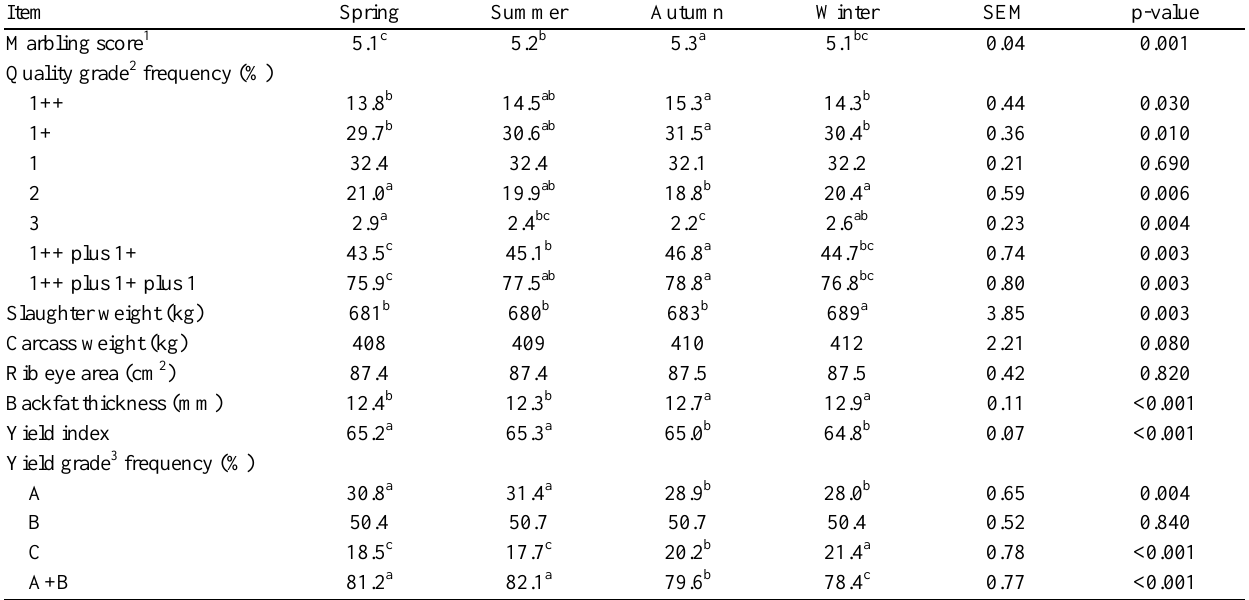
Table 6. Seasonal carcass characteristics, quality grade frequency, and yield grade frequency for 8 years (2006 through 2013) in Korean cattle steers